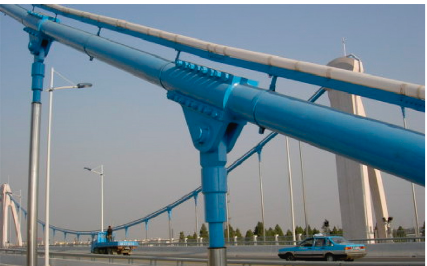
Figure 2: Cable clamp of a suspension bridge in